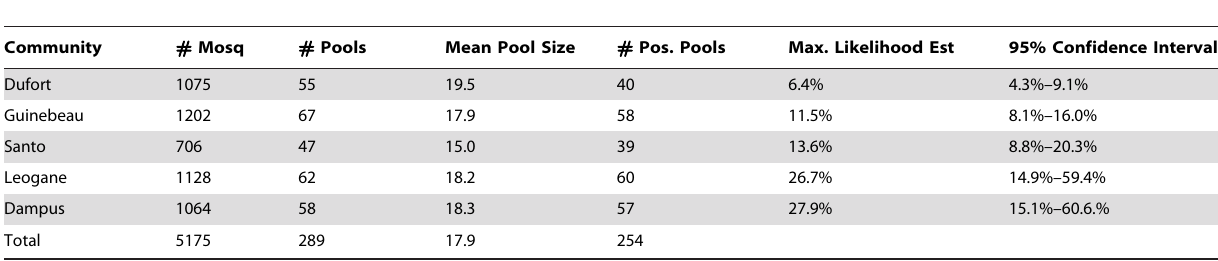
Table 3. Molecular xenomonitoring (filarial DNA rates).